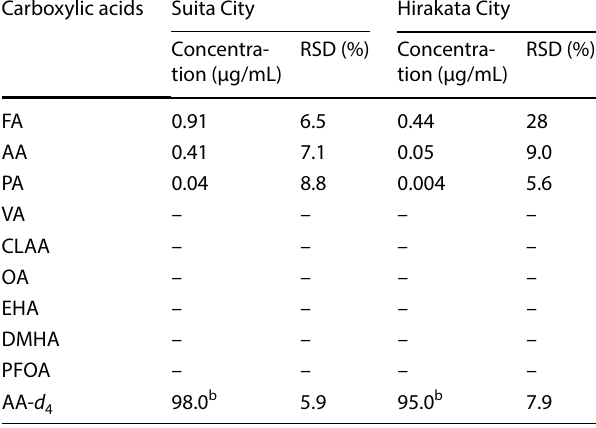
a Relative standard deviation (n = 6) b Recovery (spiked level: 1.0